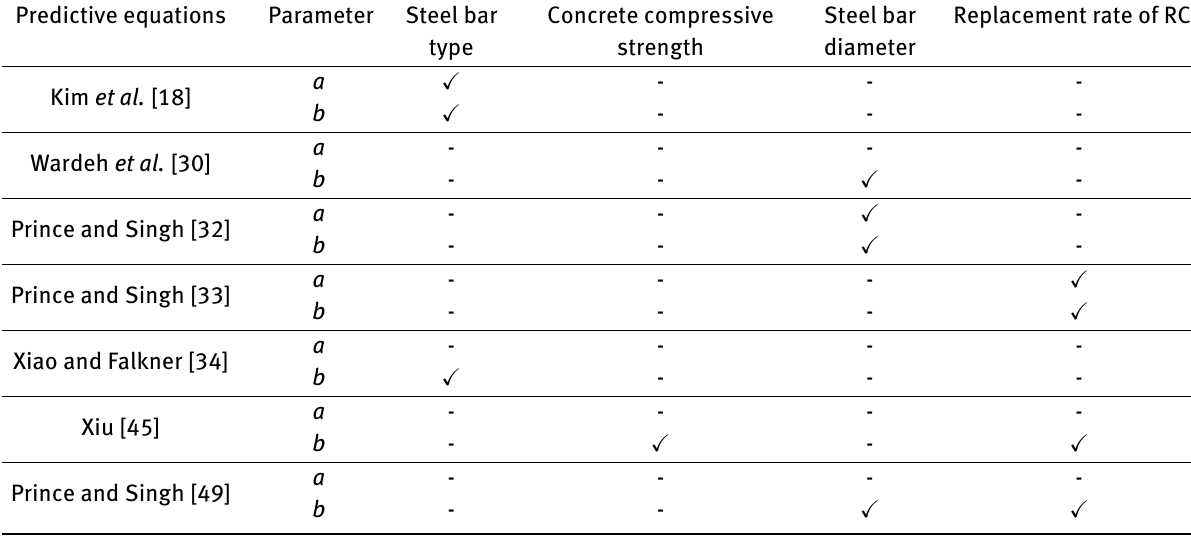
Table 3: Factors for determining parameter a and b Predictive equations Parameter Steel bar Concrete compressive Steel bar Replacement rate of RCA type strength diameter a (cid:88) - - - Kim et al. [18] b (cid:88) - - - a - Wardeh et al. [30]